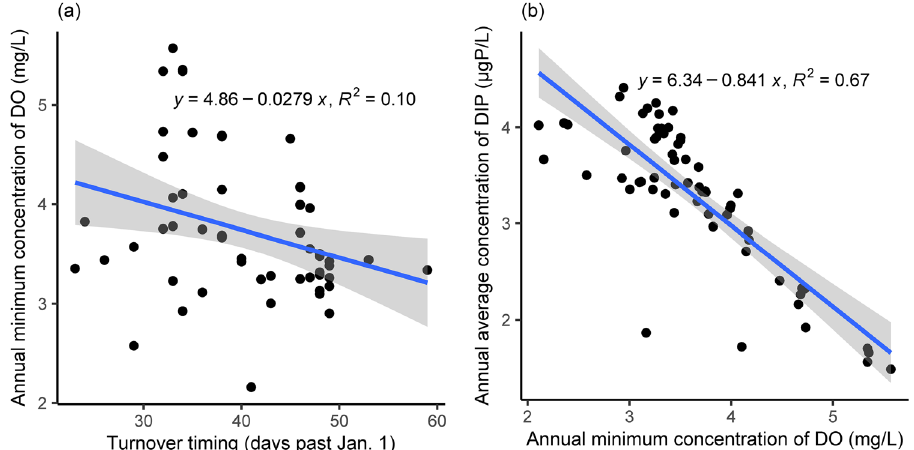
Figure 5. The linear regression results of the relationship: ( a ) between turnover timing and annual minimum concentration of DO, ( b ) between the annual minimum concentration of DO and annual average concentration of DIP. The simulation results at the monitoring station were used for